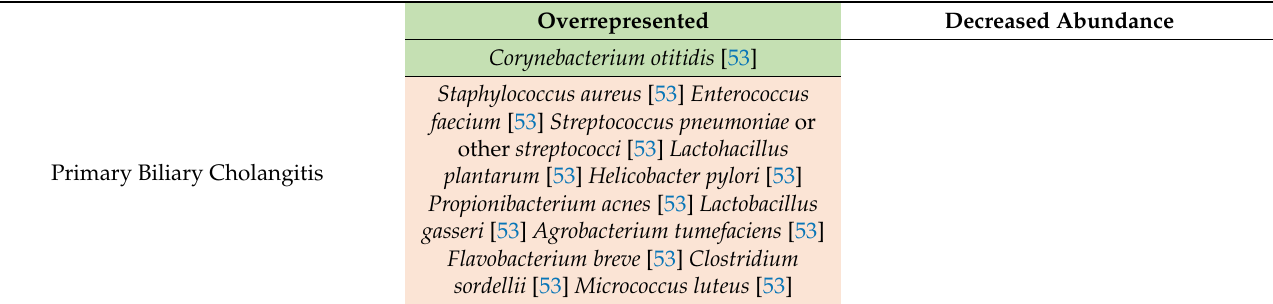
Table 1 . Taxonomy of gut microbiota in cholangiopaties. Legend: SPECIES. Table 2. Changes in biliary microbiota in cholestatic liver diseases. Table 2. Changes in biliary microbiota in cholestatic liver diseases. Table 2. Changes in biliary microbiota in cholestatic liver diseases. Table 2. Changes in biliary microbiota in cholestatic liver diseases. Table 2. Changes in biliary microbiota in cholestatic liver diseases. Table 2. Changes in biliary microbiota in cholestatic liver